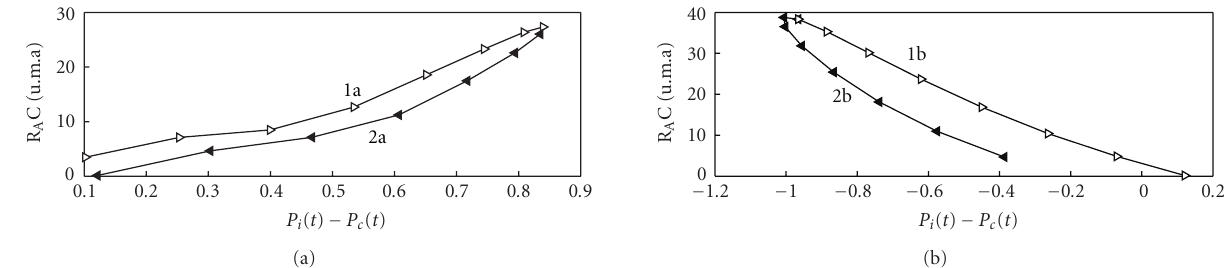
Figure 5: The vertical axis of (a) and (b) is the time constant values, and the horizontal axis is the sinusoidal modulation ( P i ( t ) − P c ( t )). The first part “1a” at the top on the resulting curves in (a) is the R A C values calculated from the positive up-going points of ( P i ( t ) − P c ( t )) and P i ( t ), “2a” obtained from the positive down-going. In (b), “1b” is obtained from the down-going points of ( P i ( t ) − P c ( t )) and P i ( t ), and “2b” from negative up-going pressures. Notice that (a) and (b) are, respectively, Figures 5(a) and 5(b).